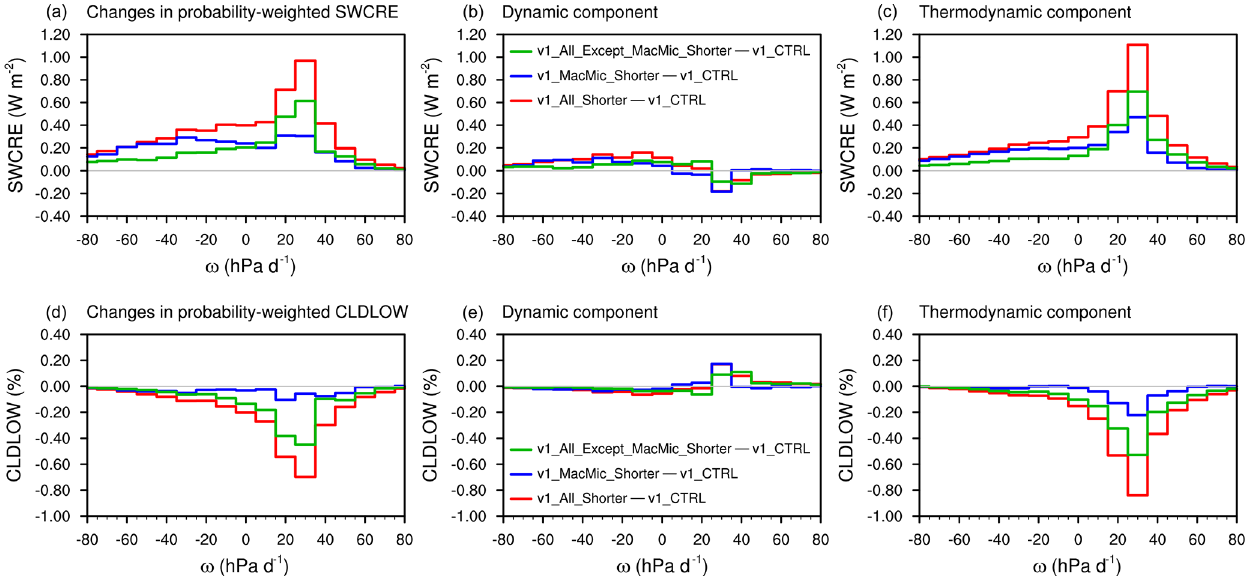
Figure 12. (a, d) Changes in the probability-weighted SWCRE (a, b, c) and low-cloud fraction (d, e, f) in circulation regimes characterized by grid-resolved 500hPa ω (see the definitions in Eqs. 5 and 6). Panels (b, e) and (c, f) show the dynamic and thermodynamic components of the changes (see Eq. 6). Details of the analysis can be found in Sect.